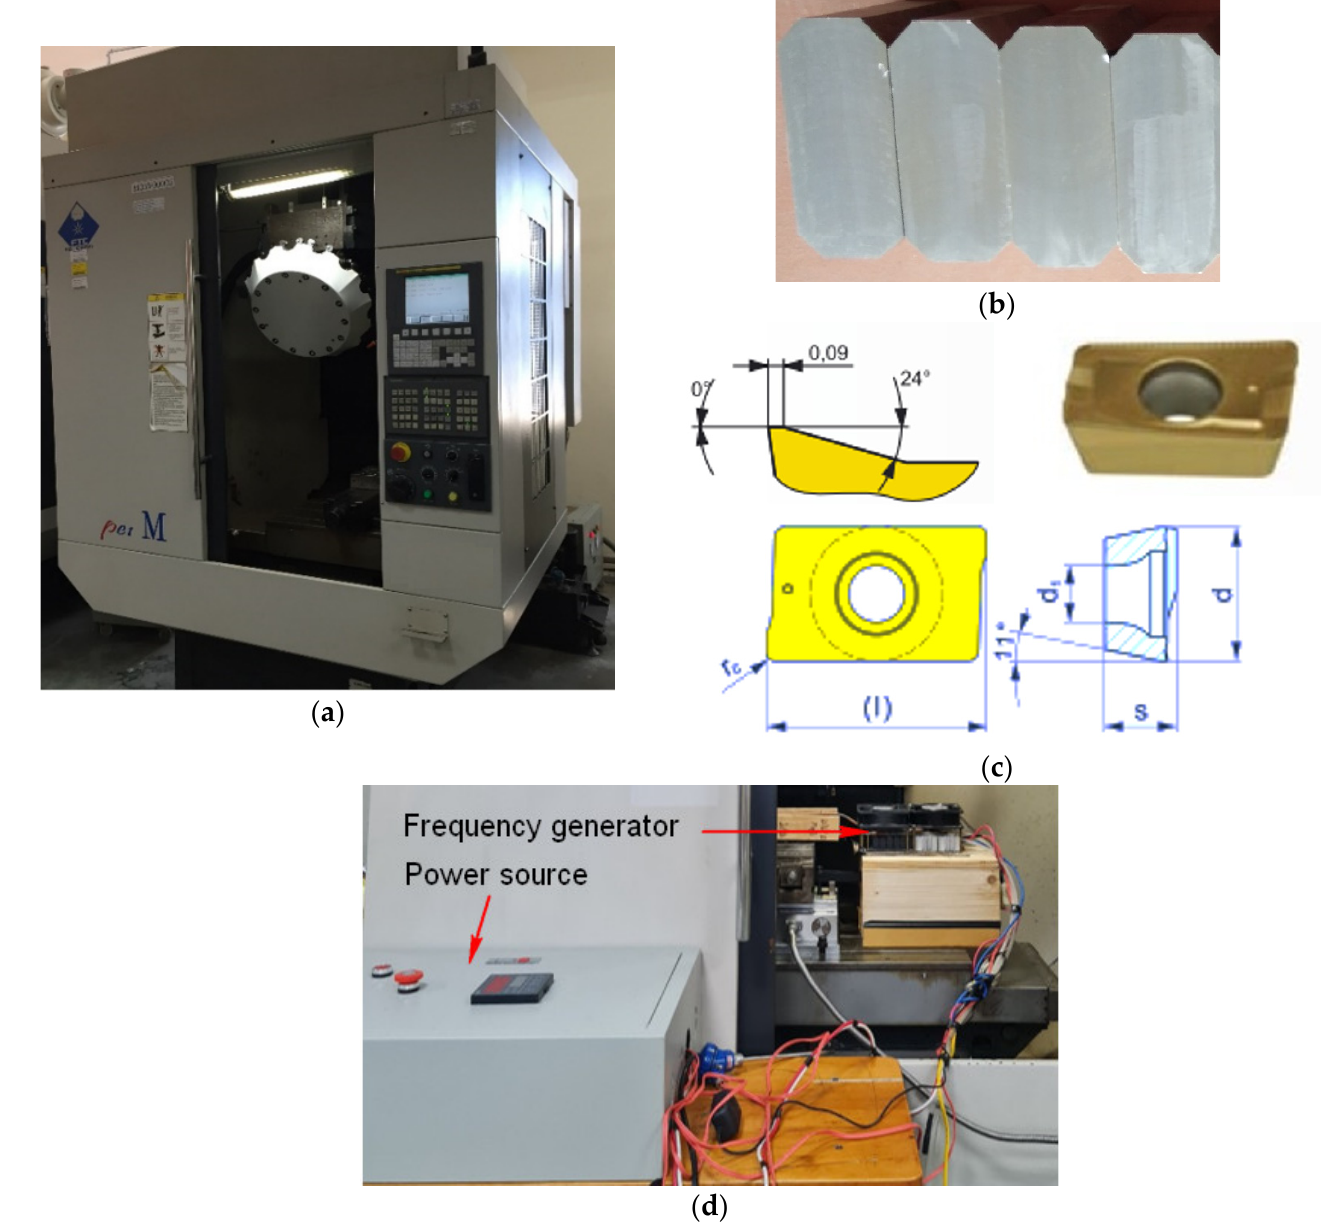
Figure 2. Components of the experimental system. ( a ) MC500 Milling Machine, ( b ) Sample Workpices, ( c ) Hard Alloy Insert, and ( d ) Power Source-Frequency Generator.